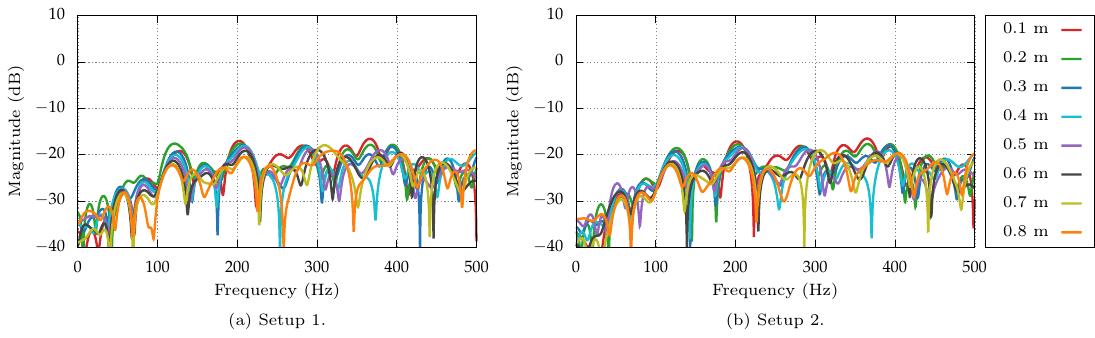
Figure 11. The amplitude functions of the frequency functions of the impulse response estimates for the paths between back casing panel’s selected actuator and one of the room microphones, at all distances, in both setups.